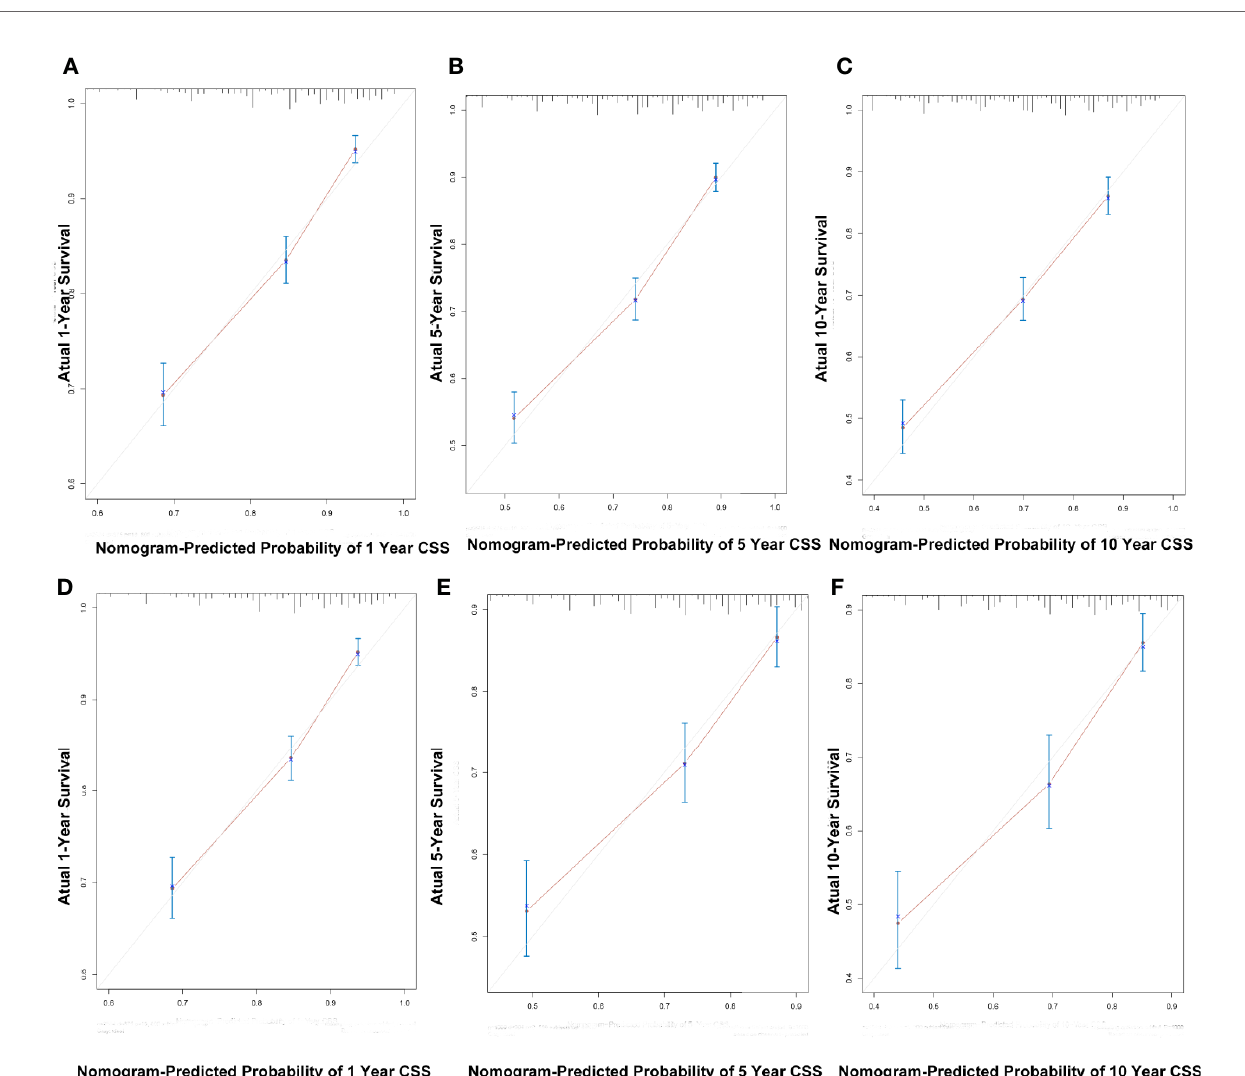
FIGURE 5 | The calibration curves for predicting patient CSS at 1-, 5-, and 10-years in the training cohort (A – C) and validation cohort (D – F)